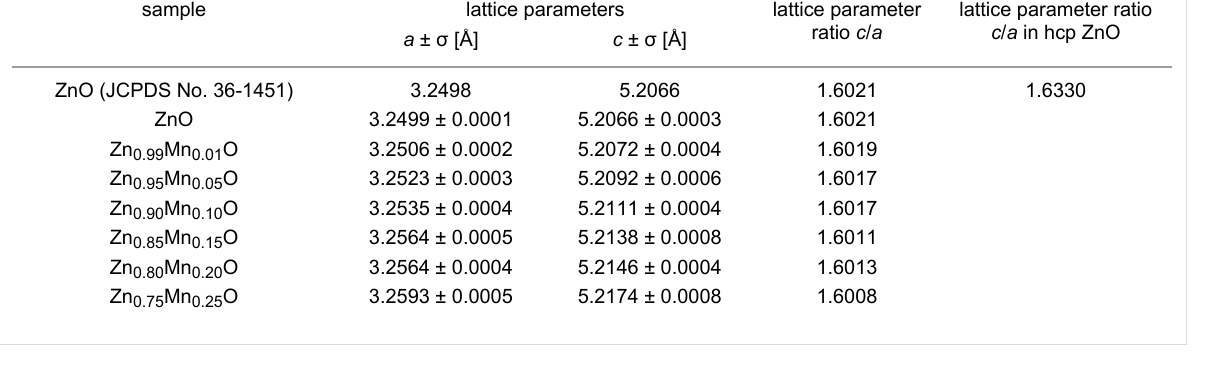
Table 2: Lattice parameters and ratio of lattice parameters of the obtained Zn 1 − x Mn x O NPs. sample